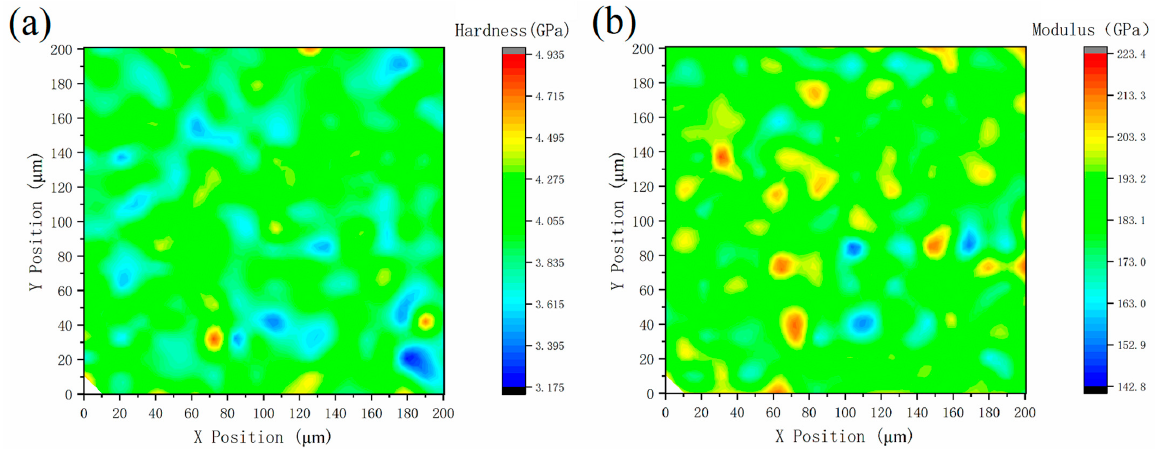
Figure 7. Surface distribution diagram of the indentation ( a ) hardness and ( b ) modulus of the SLM